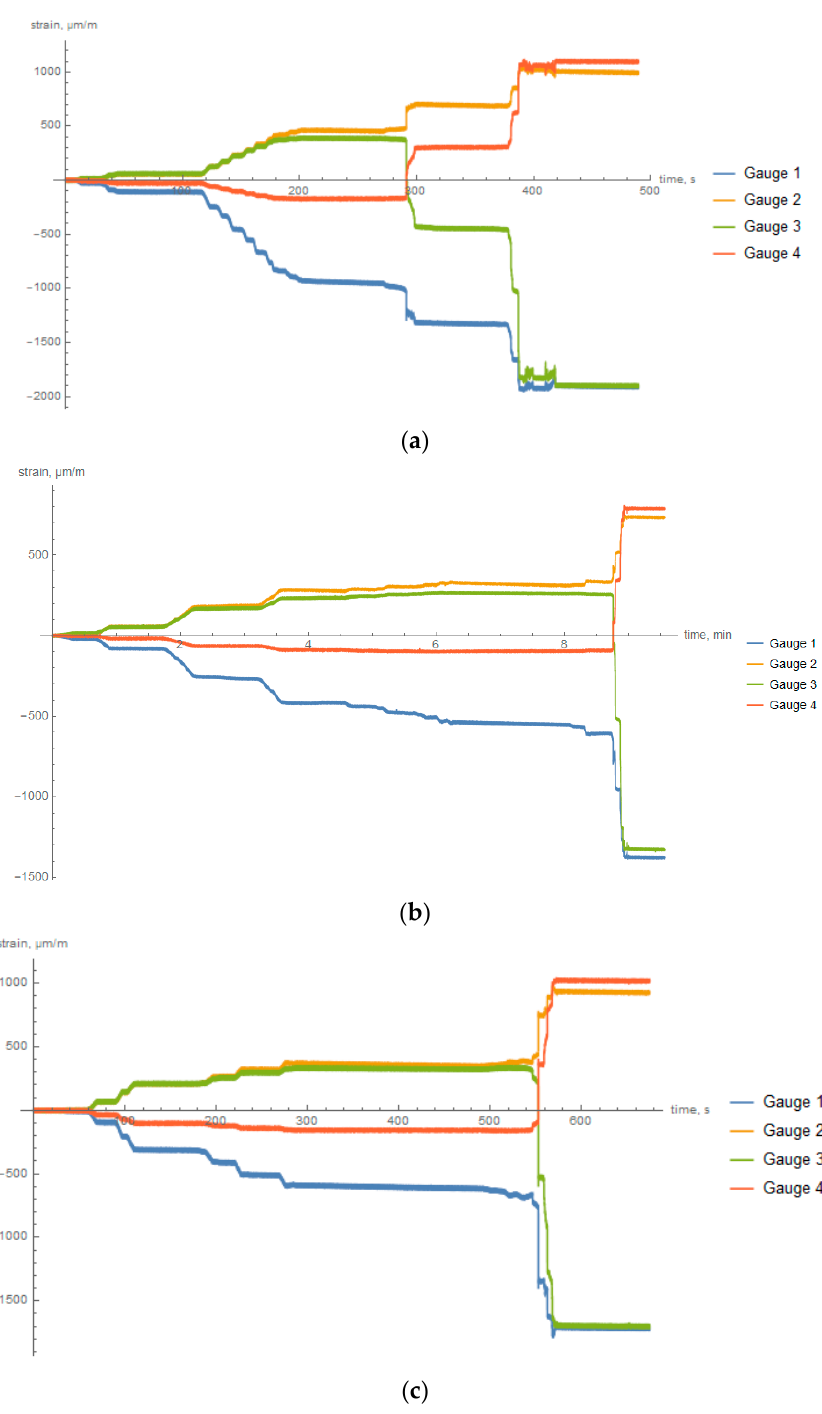
Figure 17. The strain of the composite rings during the slitting experiment, recorded on the inside and outside surfaces for: ( a ) slow cooled, ( b ) intermediately cooled, and ( c ) fast cooled rings.